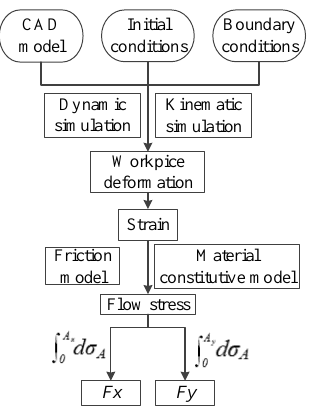
Figure 3. The procedure of numerical simulation.